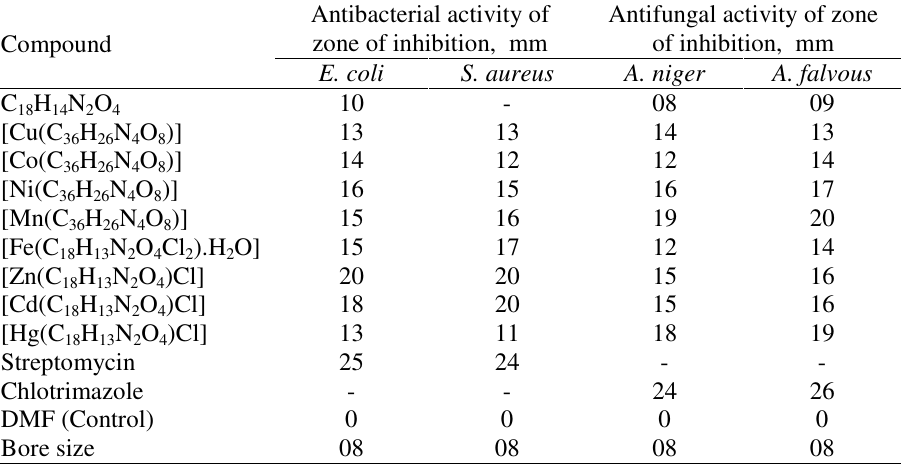
Table 5. Antimicrobial, Antifungal activity results of the ligand [HL] and its metal complexes.